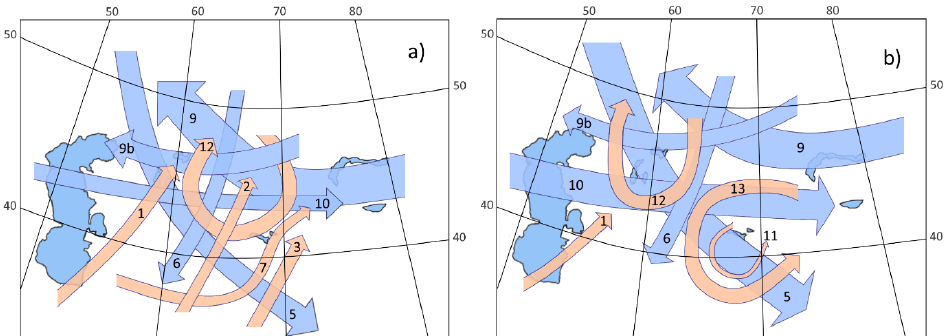
Figure 2. The regional synoptic weather types (SWT) of Middle Asia in ( a ) cold and ( b ) warm half- years. The width of the circulation type is based on occurrence frequency during the year. Adapted from Inogamova et al. [23,24].